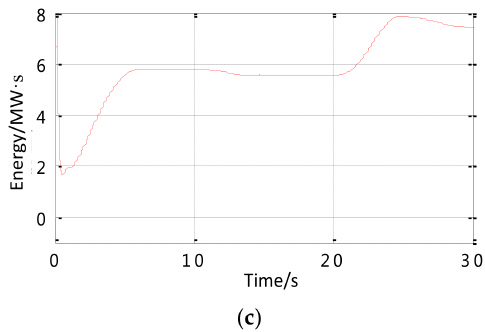
Figure 8. The change of the system frequency and the HESS output at the power fluctuation. ( a ) The system frequency responses with and without inertia control; ( b ) Output power response of HESS; and ( c ) Output energy response of